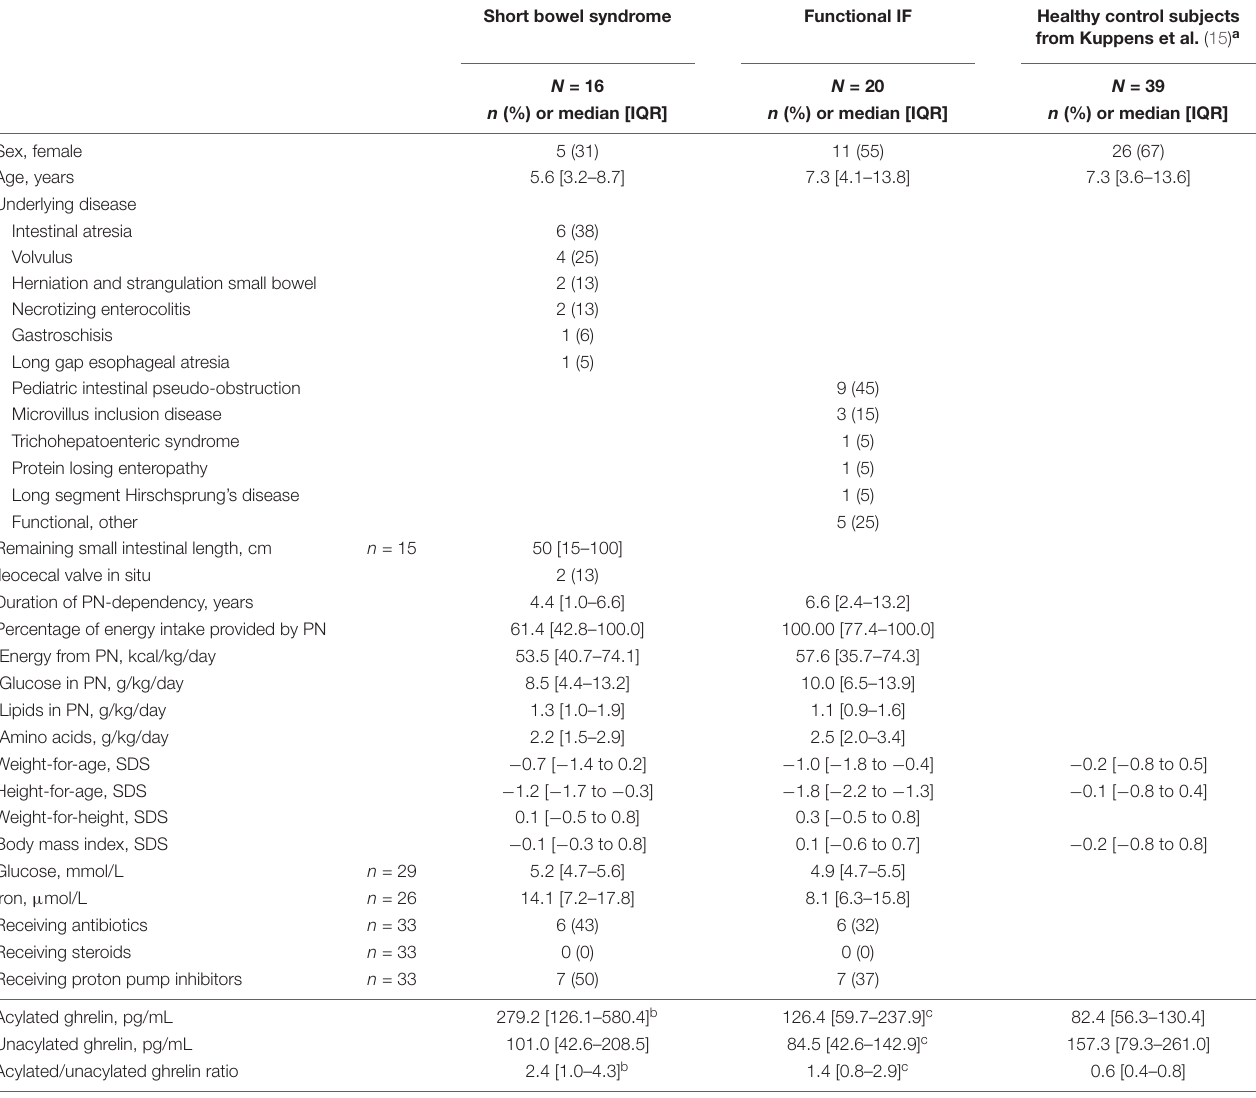
TABLE 1 | Patient characteristics at the time of the first ghrelin measurement.